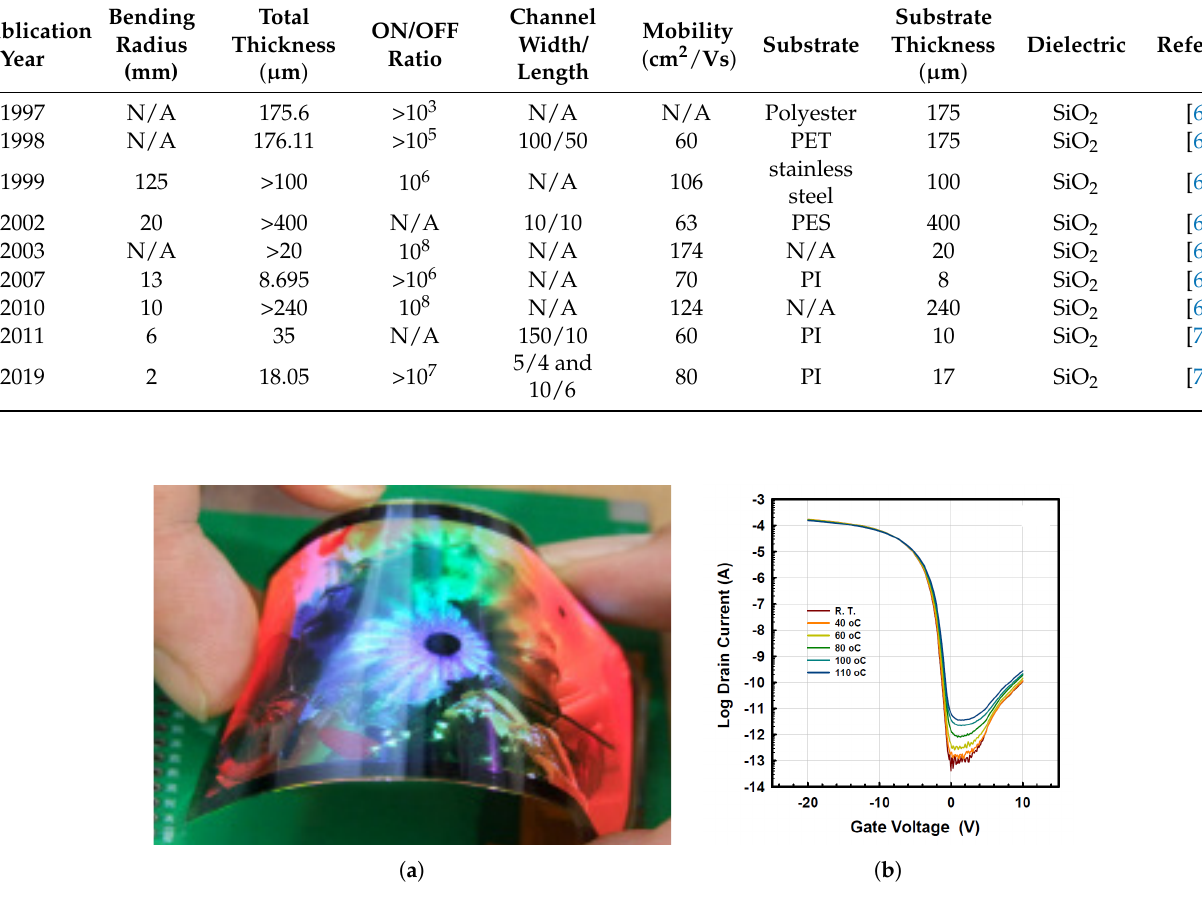
Figure 6. An example of one of the original physically flexible LTPS TFTs [69]. ( a ) Photograph of a flexible substrate with TFTs and circuits. ( b ). Transfer curve of a since LTPS device. Reproduced with